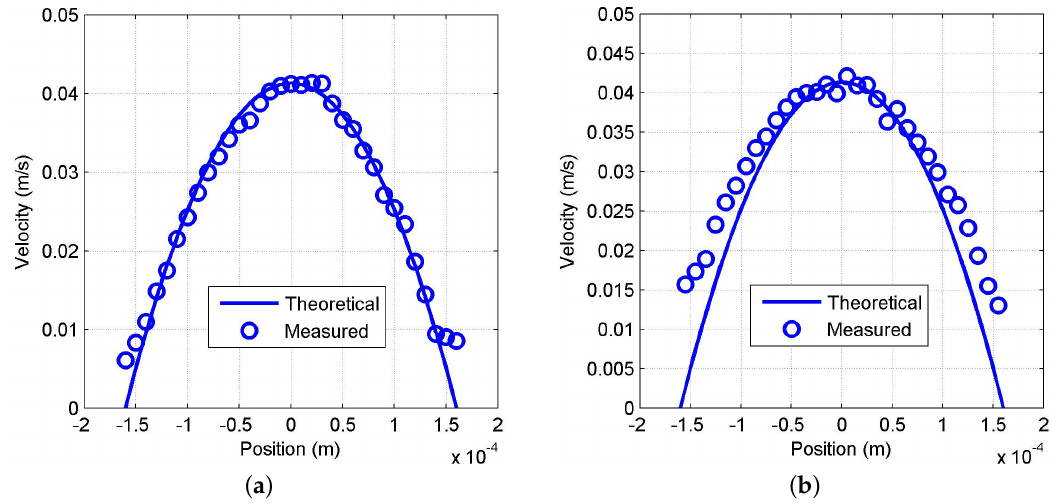
Figure 11. Experimental (circles) and theoretical (solid line) fluid velocity profile for the circular channel (320-µm diameter) with a 100-µL/min flow rate of diluted milk: ( a ) 2% w / w dilution, profile obtained by cutoff frequency method; ( b ) 10% w / w dilution, profile obtained by the weighted moment